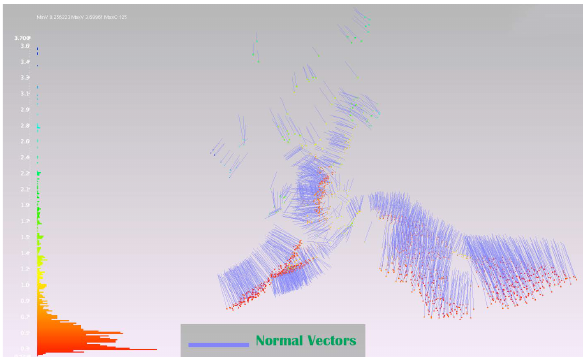
Figure 4. Points coloured by density and normal represented as vectors. Remaining vegetation points are characterized by coherent normal, but low local densities.